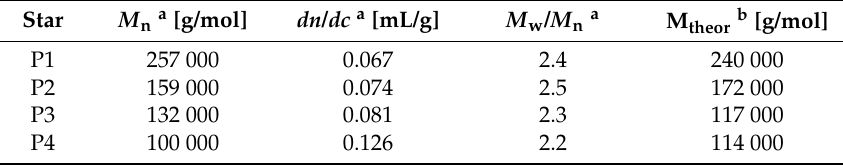
Figure 1. 1 H NMR spectrum (CDCl3, 600 MHz) of P(DMAEMA- co -OEGMA-OH) star (sample P4, Table 1). Table 2. Molar masses of the P(DMAEMA- co -OEGMA-OH) star copolymers.